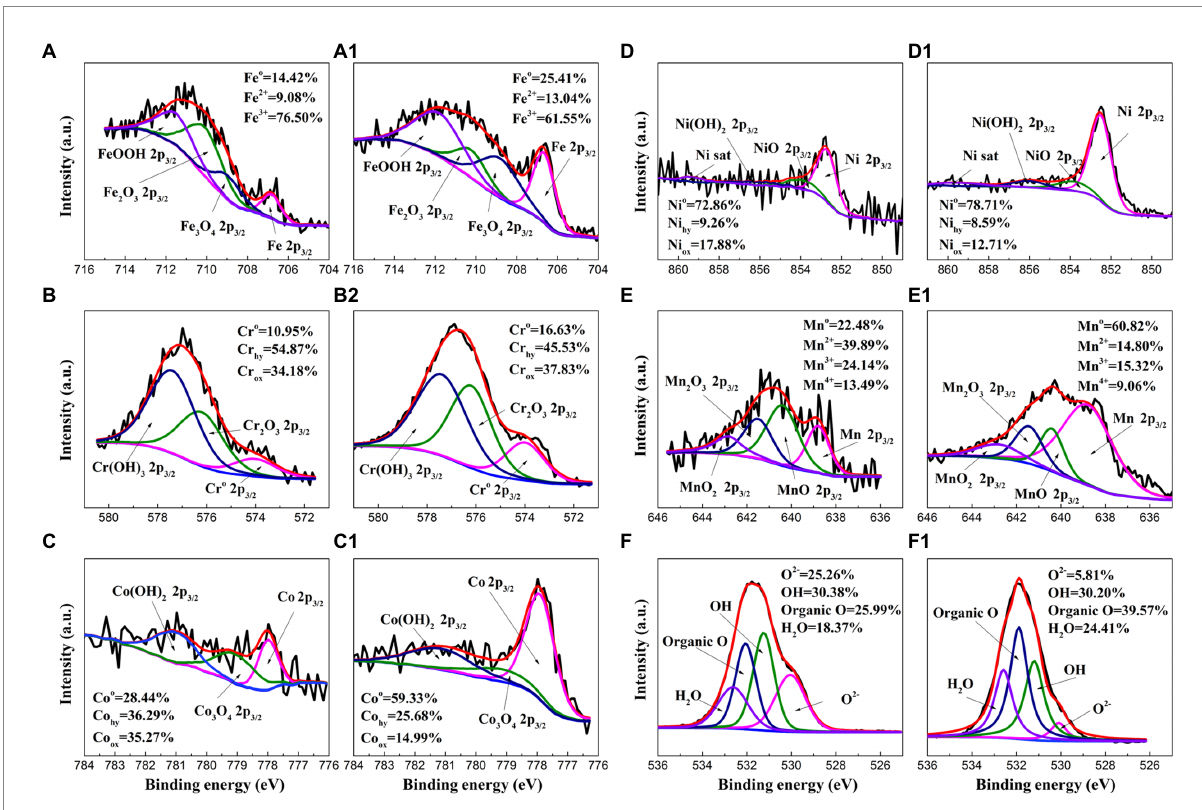
FIGURE 8 High-resolution XPS spectra of Fe 2p3/2 , Cr 2p3/2 , Co 2p3/2 , Ni 2p3/2 , Mn 2p3/2 and O 1s for the HEA coupon surface after immersion in the sterile (A–F) and the P. aeruginosa -inoculated medium (A1–F1) for 14 days.